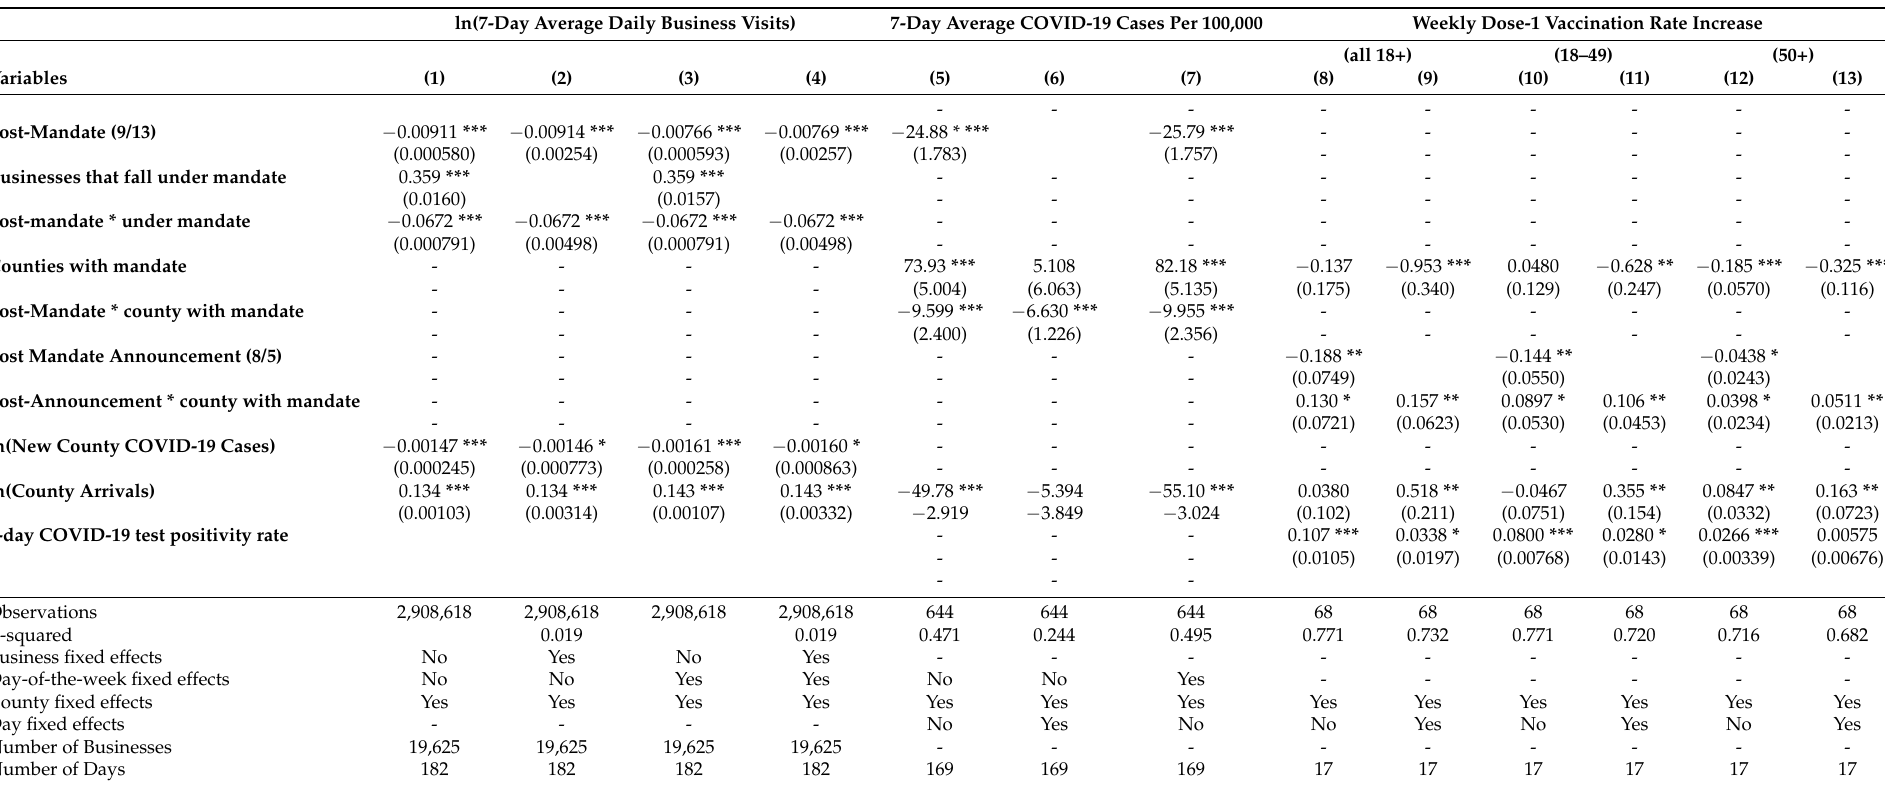
Table 2. Results for difference-in-difference regressions are described in Equations (5)–(8). The interaction terms estimate the impact of the mandates on businesses and counties that are impacted following announcement or implementation. These represent the change in the trend between impacted and non-impacted businesses or counties following the shock of the mandates, making these our coefficients of